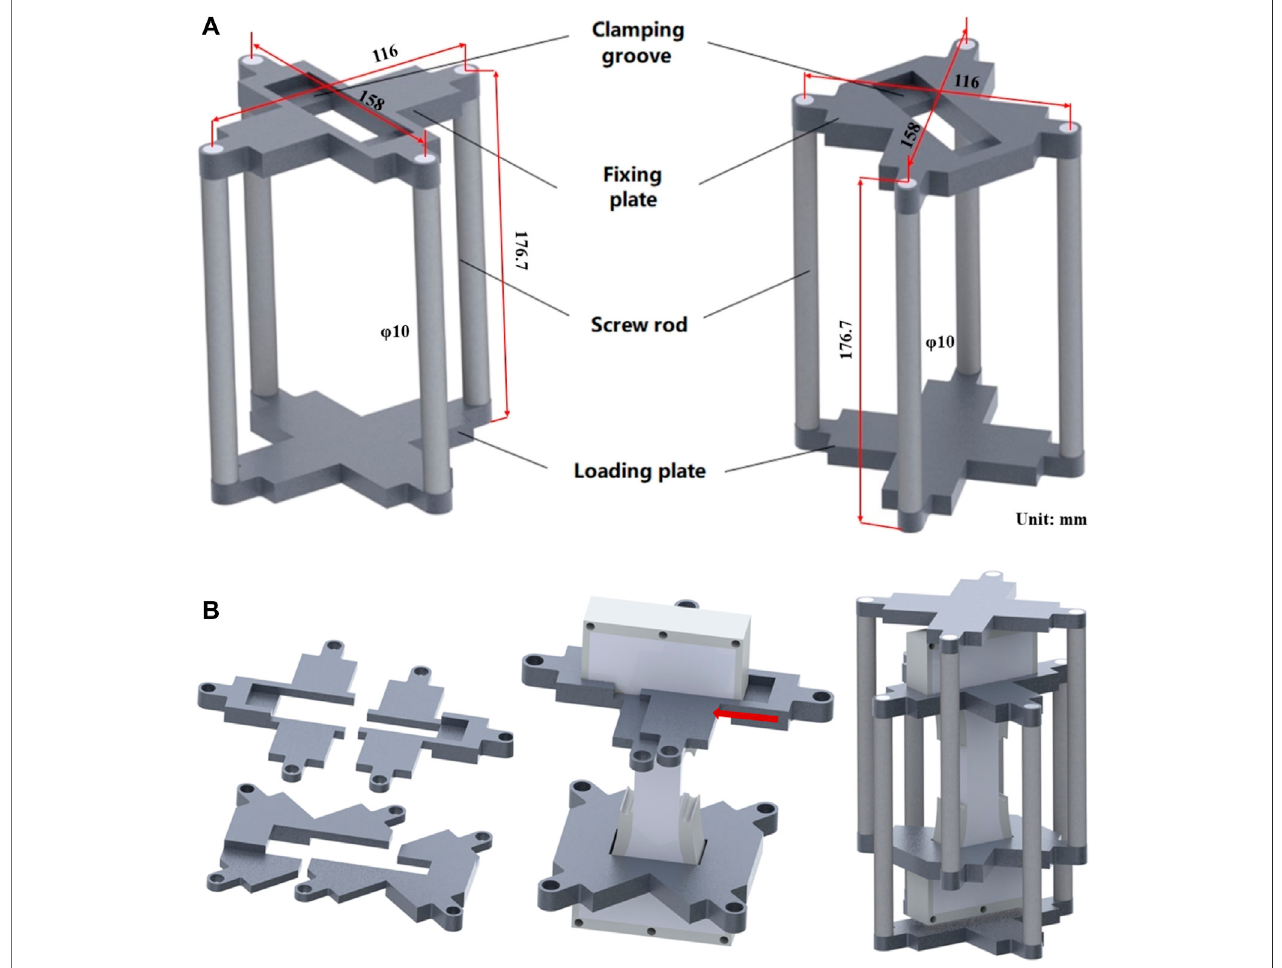
FIGURE 2 | Compression to tension load converter: (A) different parts of the apparatus and (B) the assembly of the apparatus.